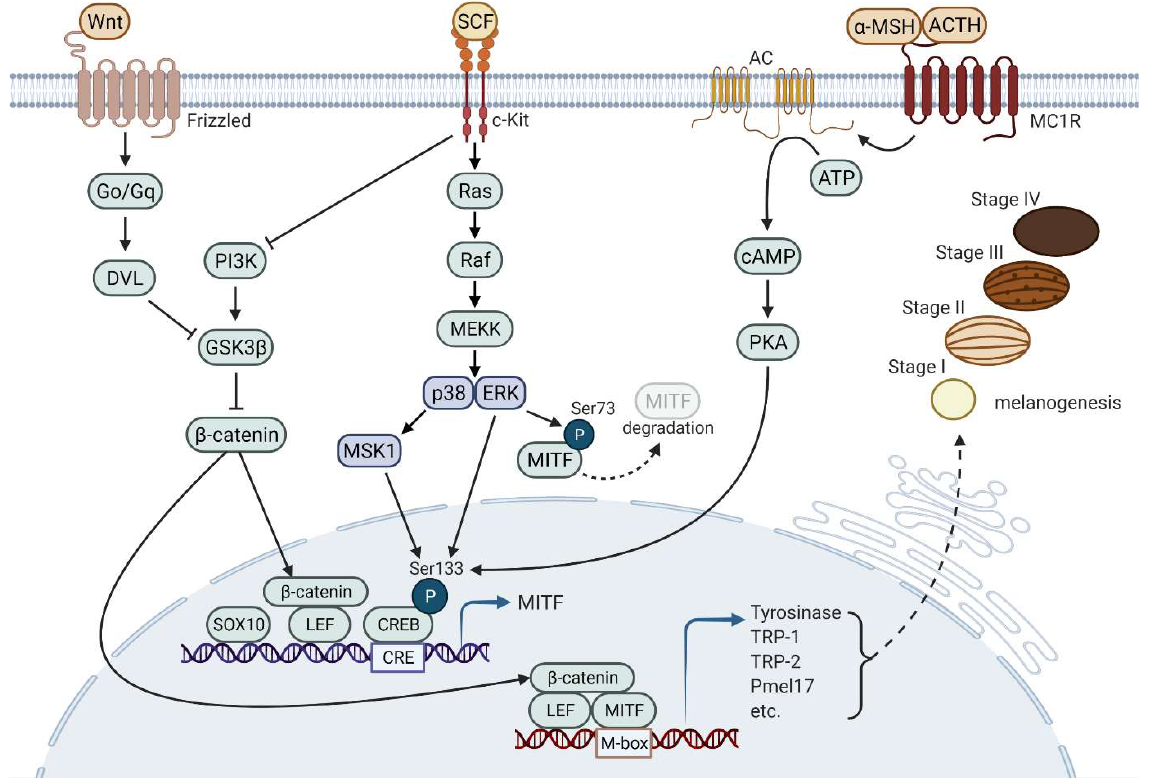
Figure 1. Signaling pathways that induce melanogenesis. Three representative signaling pathways, including MC1R-mediated signaling, SCF/c-KIT signaling, and Wnt signaling, are involved in melanogenesis. Expression and activation of MITF induce the expression of various proteins that play important roles in the formation and maturation of melanosomes as well as melanin synthesis. The continuous reaction of enzymatic proteins (e.g., TYR and TRP-1/2) and structural proteins (e.g., Pmel17) leads to melanogenesis in melanosomes wherein melanin pigments are synthesized and stored. DVL, Disheveled; Go/Gq, main families of G proteins.